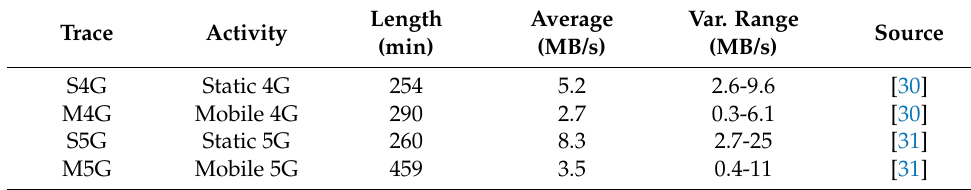
Table 1. Network capacity traces used in the